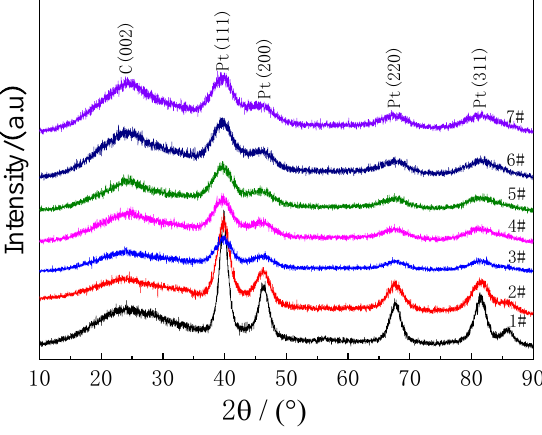
Figure 2. XRD patterns of the seven groups of catalysts.